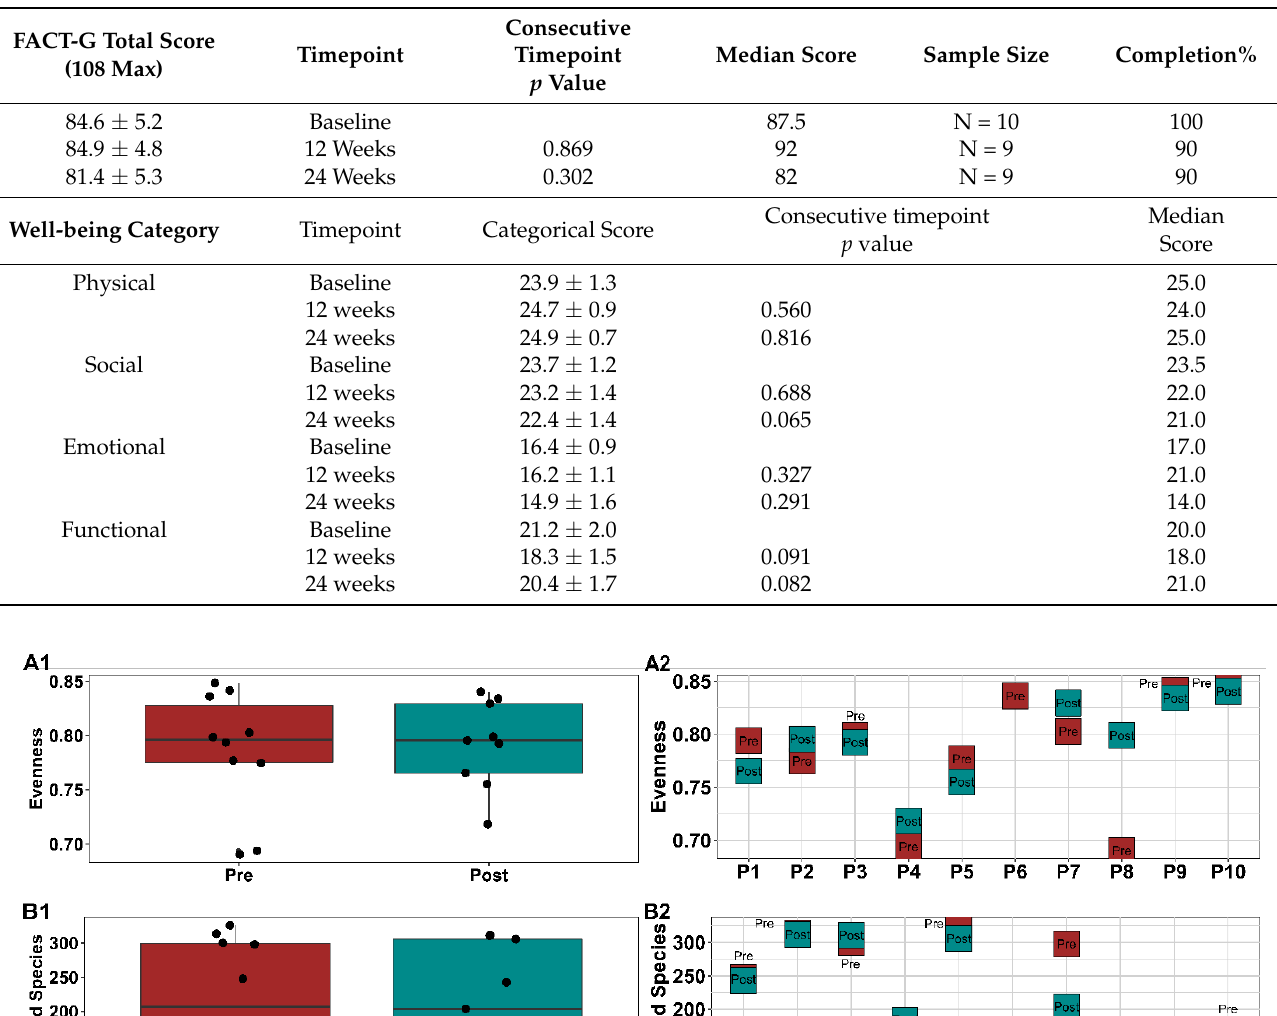
Table 7. FACT-G questionnaire results.